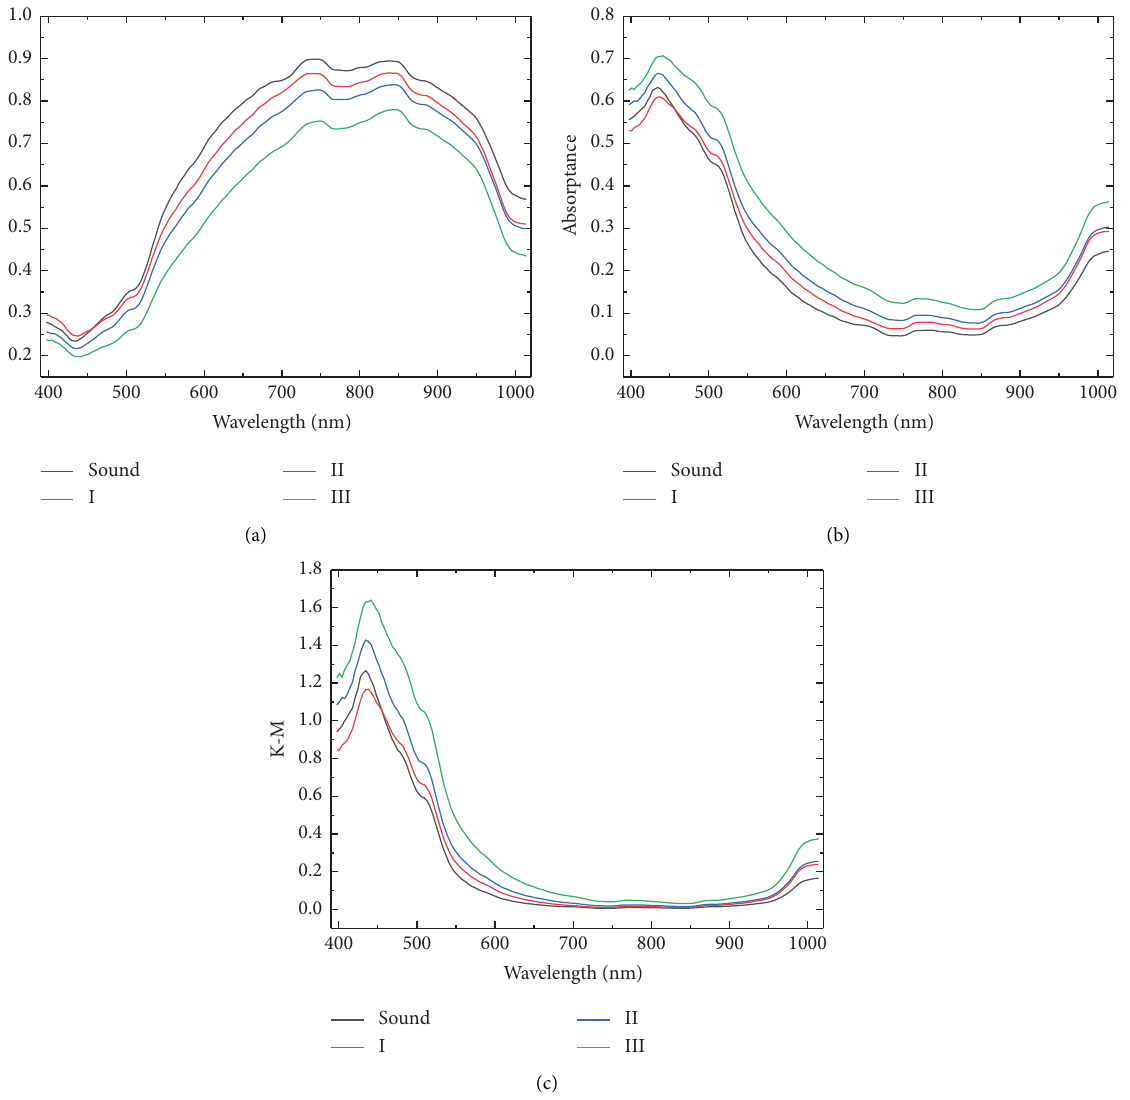
Figure 3: Raw spectral curves of(a) R , (b) A and, (c) K - M